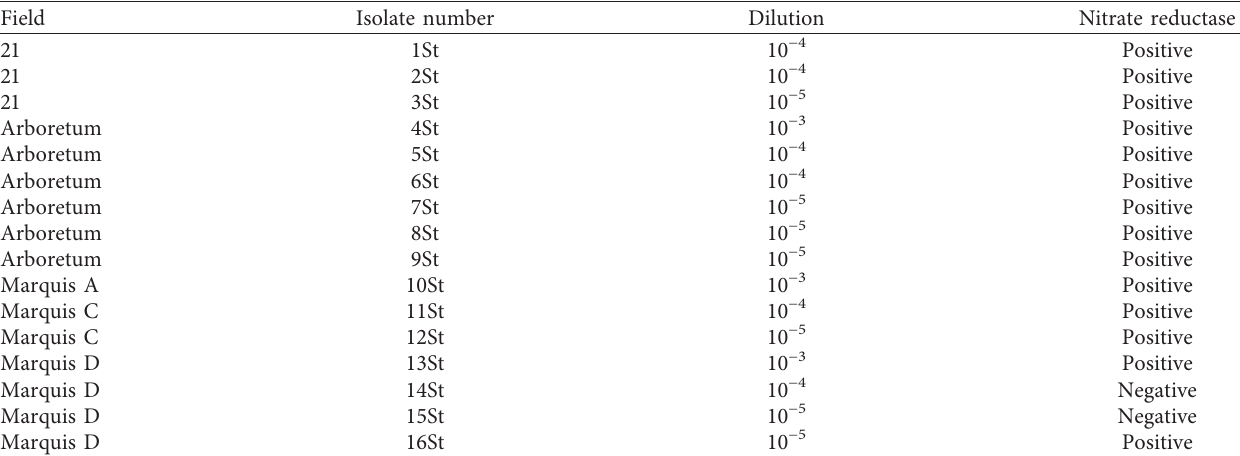
Table 5: Isolates of Streptomyces from Pierce Farm and nitrogen reductase